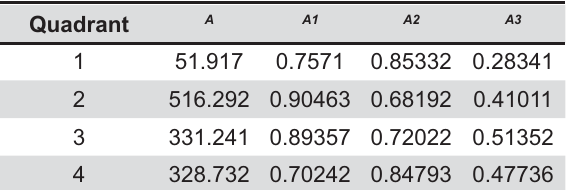
Table 2- Optimal values of parameters for multiple linear regression equations provided by the Breeder genetic algorithm